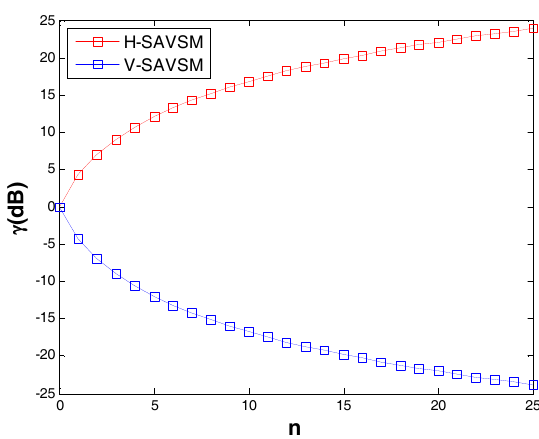
Figure 2. Dependence of the co-polarization power ratio γ on the value of power variable n .